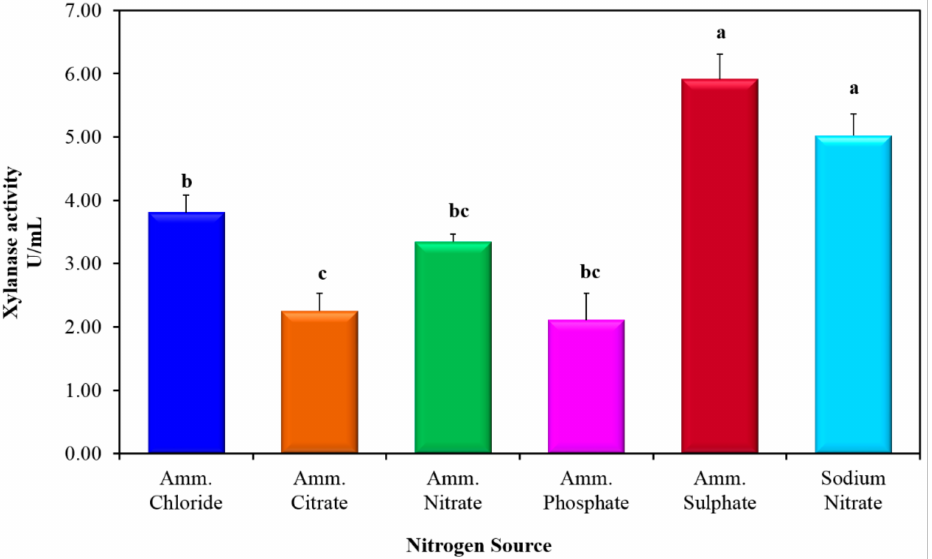
Figure 3. Influence of the nitrogen source on the production of xylanase from P. chrysogenum A3 DSM105774 at 35 ◦ C. Values are mean of 4 readings with standard error (SE). Symbols (a, b, and c) displayed on histogram bars were used to distinguish the significance in the xylanase levels imposed by different inorganic nitrogen sources. The histogram bars bearing the same symbol letter indicated non-significant difference. The histogram bars bearing different symbol letters indicated a significant difference at p -value ≤